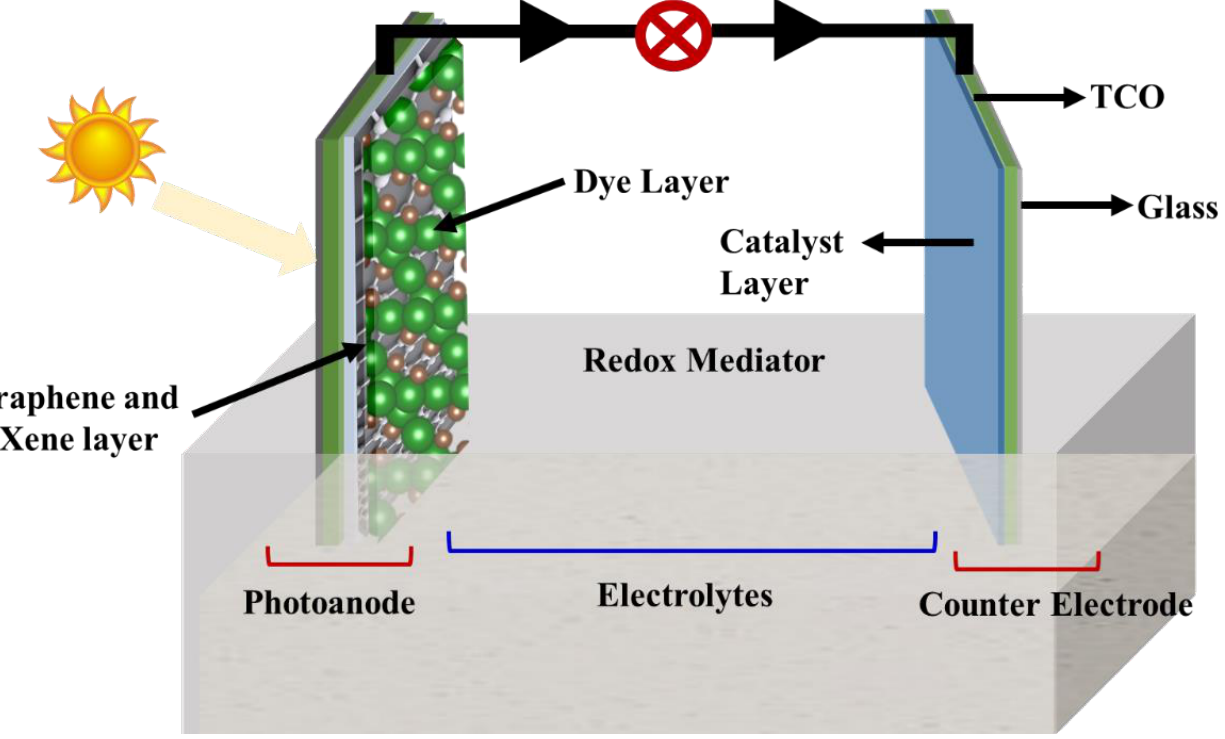
Figure 1. Schematic illustration of the different components of DSSCs.